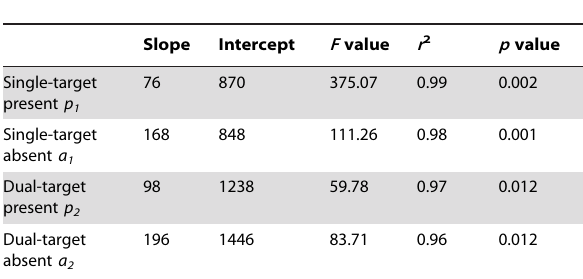
Table 4. Regression statistics for mean RT-by-set-size functions by search and trial type. Intercept and slope values are reported in milliseconds and milliseconds per item